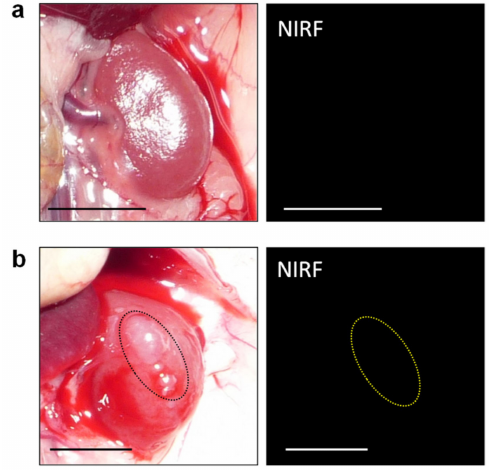
Figure 4. Representative real-time near-infrared fluorescence (NIRF) imaging of healthy ( a ) and cancerous ( b ) kidneys. Images were obtained at 6 h after the intravenous administration of ASP5354 (12 nmol/kg body weight) in mice. Tumor is within the dotted circle. Scale bar = 10